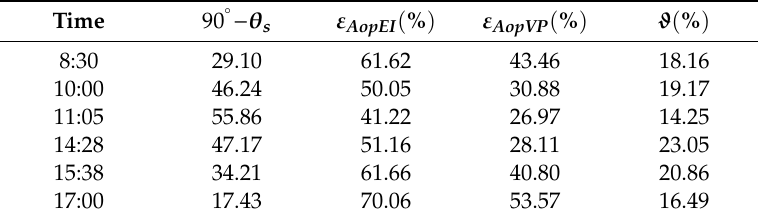
Table 1. Similarity and improvement of equidistance imaging, two-dimensional Rayleigh simulation and actual measurement.